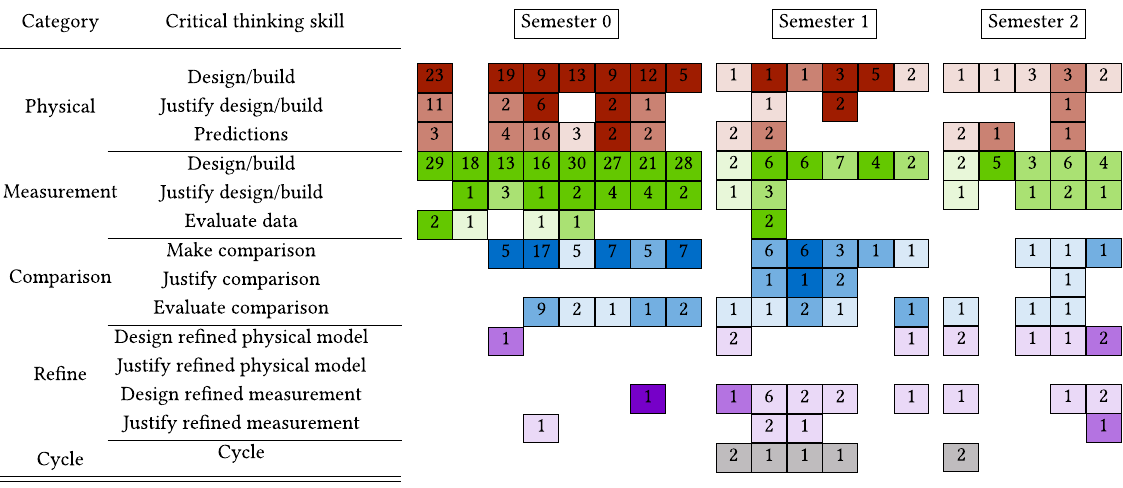
FIG. 4. Collapsed representation of coding for the lab instructions for each activity; one activity is a single column. Dark shades represent less available agency and lighter shades represent more available agency; the statement coded with the least available agency was used to determine the shade. The numbers represent the number of times statements were coded within the lab instructions for that activity. Activities are ordered by timing from first of the semester (left) to the final activity of the semester